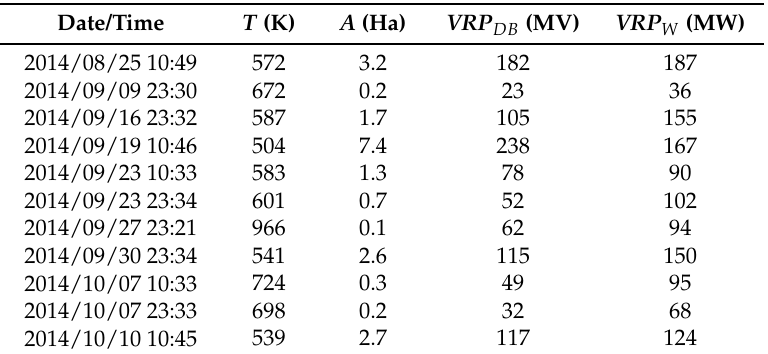
Table 7. Temperature ( T ), area ( A ), and volcanic radiative power estimated using dual band ( VRP BD ) and Wooster’s method ( VRP W ) for TET-1 cloud free